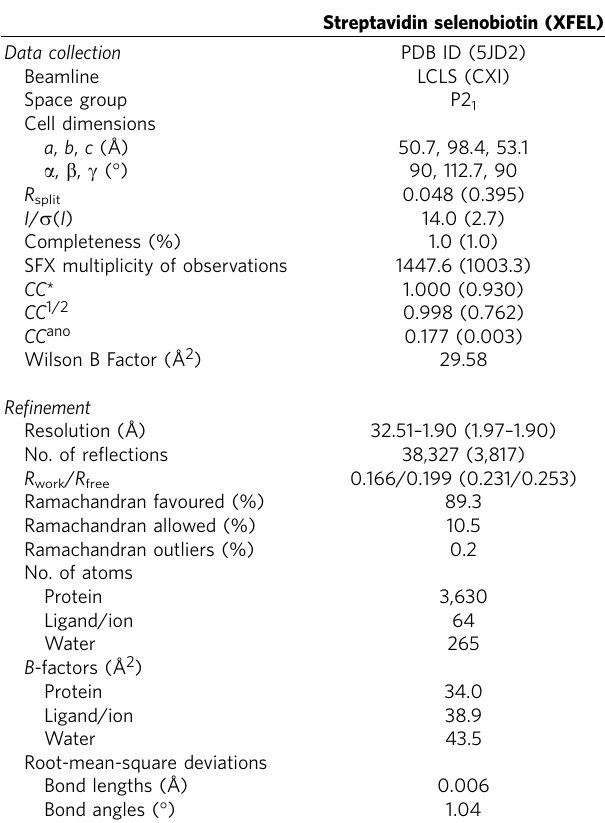
Table 1 | Data collection and refinement